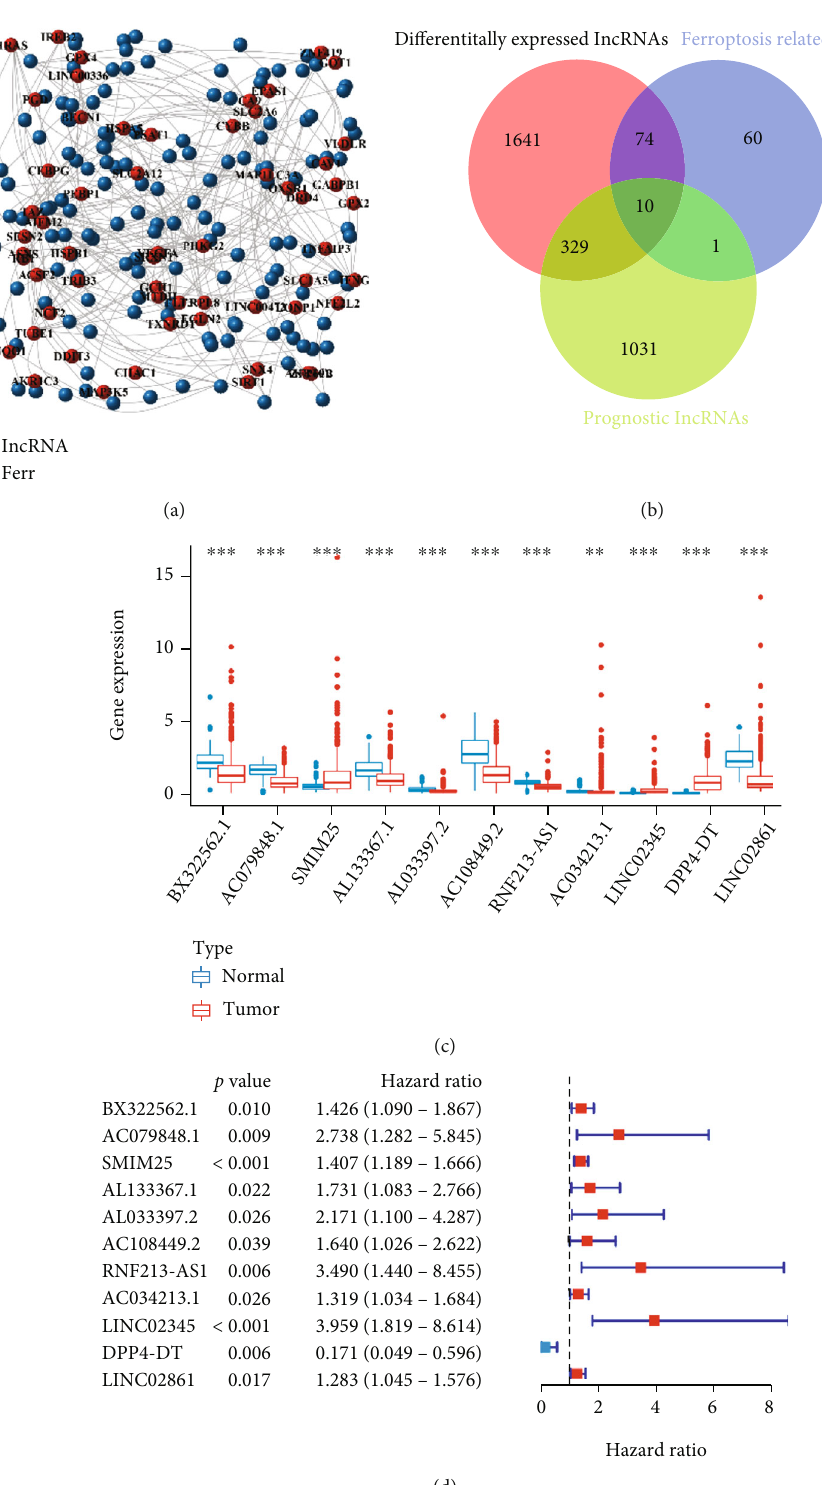
Figure 1: Identi fi cation of Ferr-associated prognostic lncRNAs in TC. (a) Coexpression network diagram of the 60 Ferr-associated genes and 145 lncRNAs. (b) Venn diagrams to identify common lncRNAs of di ff erentially expressed lncRNAs, Ferr-associated lncRNAs, and prognostic lncRNAs. (c) The 11 overlapping lncRNAs were di ff erentially expressed in normal and tumor tissues. (d) Forest plot of univariable regression analysis results of the 11 selected Ferr-associated lncRNAs. The “ ∗∗ ” represents the statistically signi fi cant P value < 0.01, and ∗∗∗ P < 0 : 001